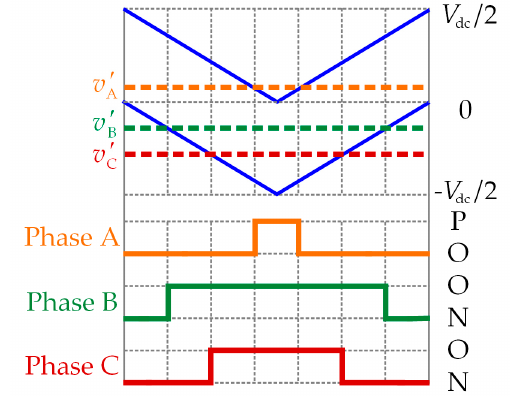
Figure 4. The switching sequence in a unit carrier period.